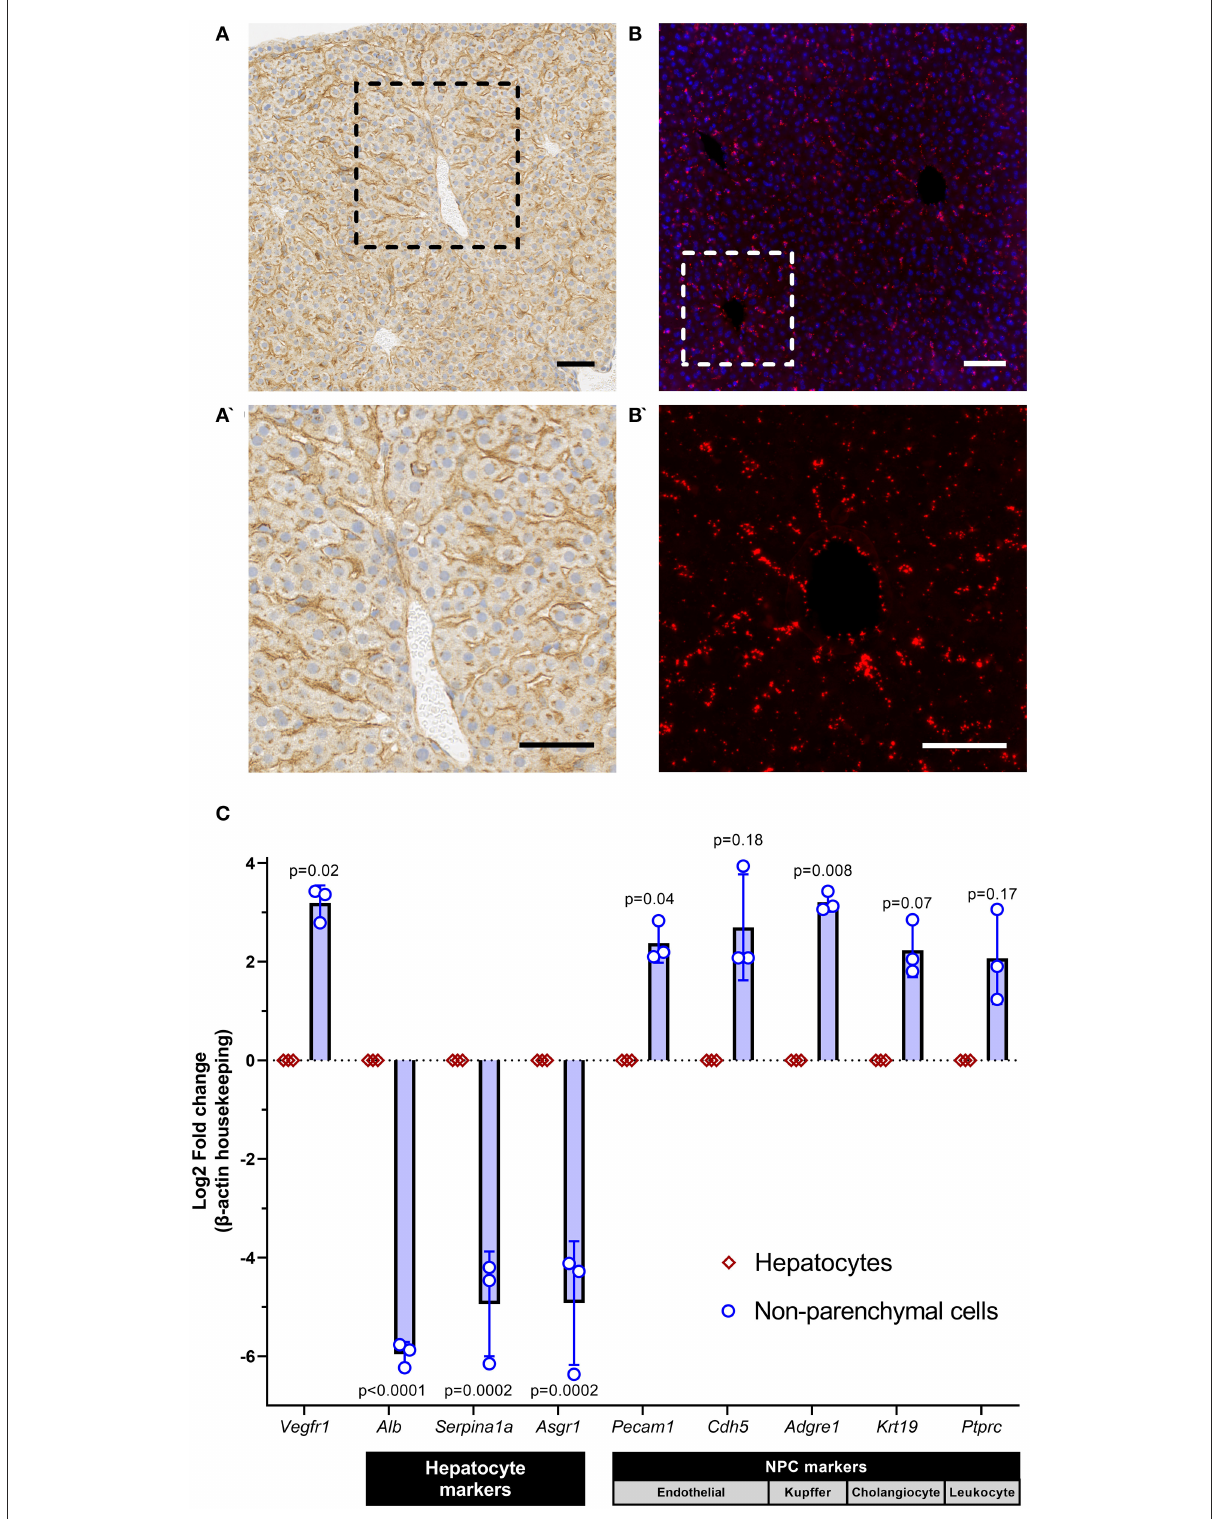
FIGURE1 sVEGFR1 is not significantly expressed by hepatocytes in the liver. (A,A’) Immunohistochemistry of mouse liver demonstrates strong staining in the sinusoidal regions of the liver with negligible staining in hepatocytes; scale bar 50 µ m. (B,B’) RNAscope of mouse liver demonstrates hybridization signal in the sinusoidal regions of the liver; scale bar 50 µ m. (C) Quantitative RT-PCR of isolated hepatocytes and non-parenchymal cells (NPCs) shows significantly greater expression of Vegfr1 in NPCs compared to hepatocytes; n = 3 wild-type mice and supporting gene expression patterns to confirm isolation of pure cell populations. Analysis with paired t